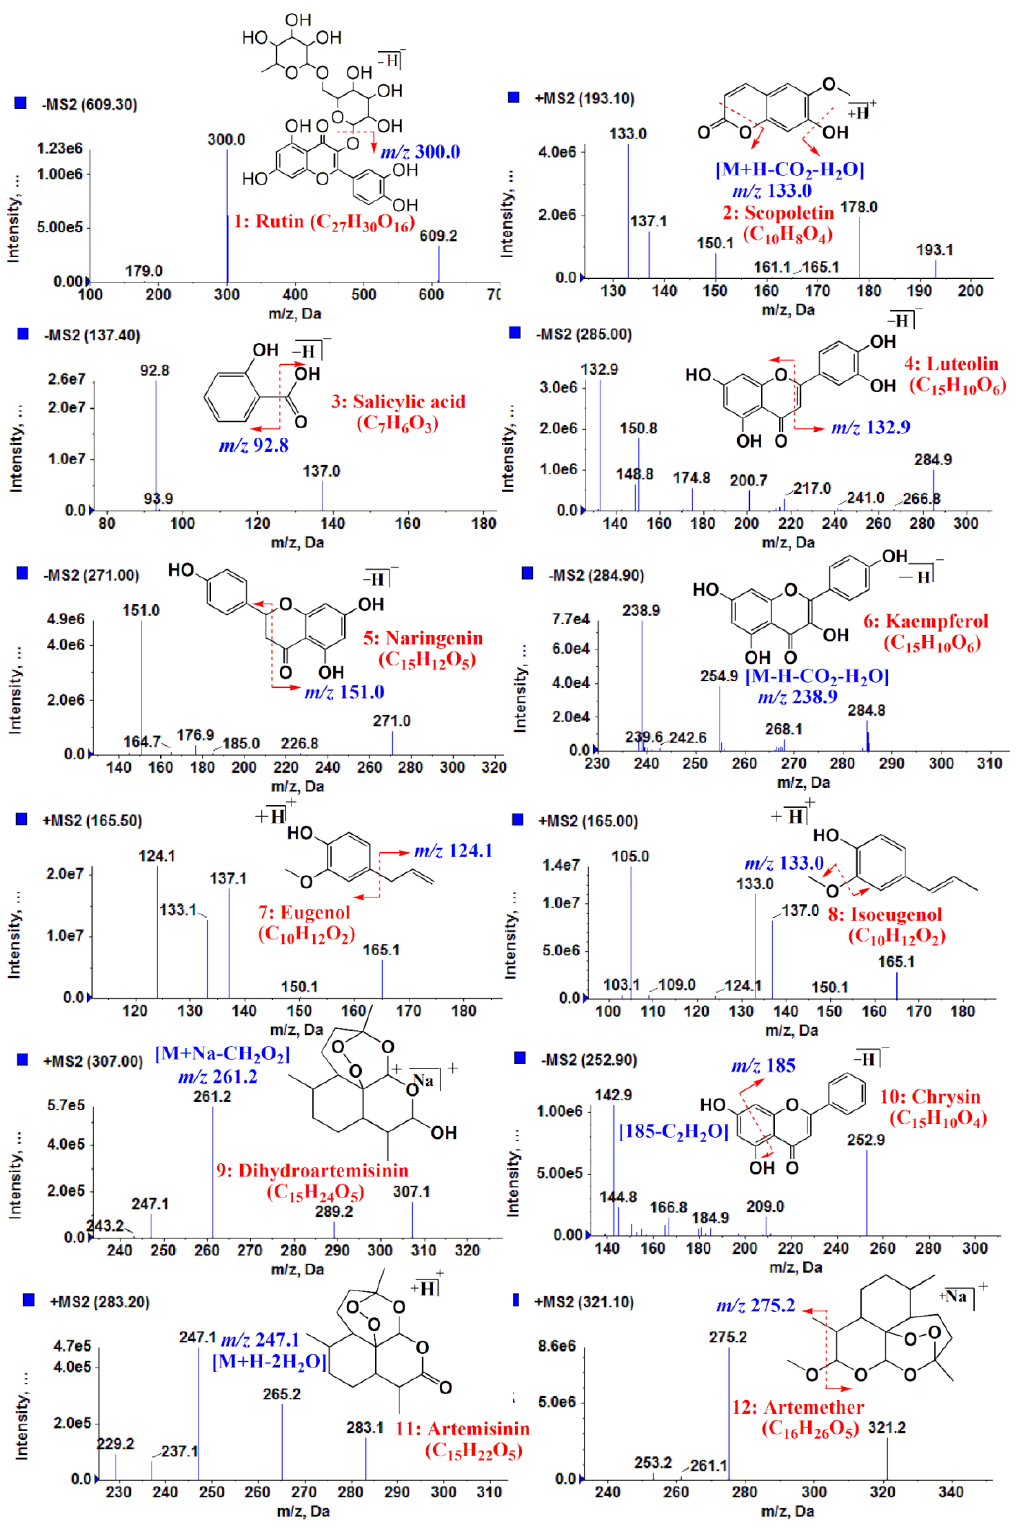
Figure 6. ESI-MS/MS spectra in positive and negative mode in addition to MRM transitions of various Artemisia species [42]. As per the report, peaks 1, 4, 5, 6 and 10, were identified as rutin, luteolin, naringenin, kaempferol and chrysin respectively. Peaks 7 and 8 were detected as eugenol and isoeugenol and peaks 9, 11 and 12 were detected as dihydroartemisinin, artemisinin and artemether,